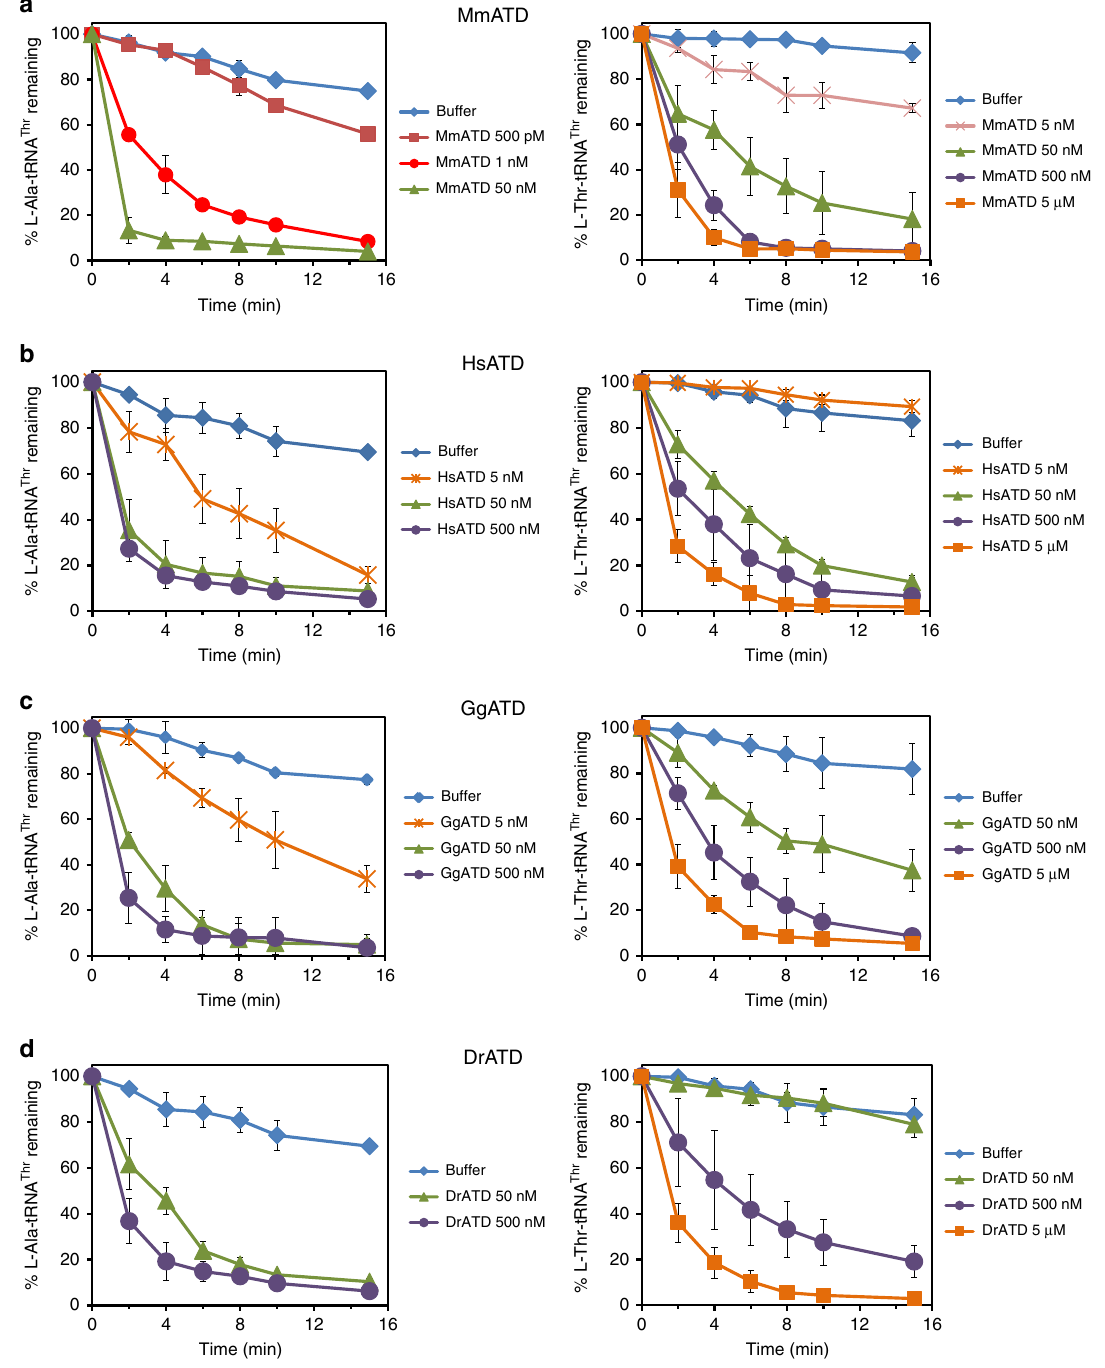
Fig. 5 Proofreading of L-Ala-tRNA Thr (G4 (cid:129) U69) by ATD is conserved across organisms. Deacylation of L -Ala-tRNA Thr (G4 (cid:129) U69) and L -Thr-tRNA Thr (G4 (cid:129) U69) by different concentrations of a MmATD, b HsATD, c GgATD, and d DrATD. Aminoacyl-tRNAs were used at 200 nM fi nal concentration. Er`ror bars denote one standard deviation from the mean of three independent